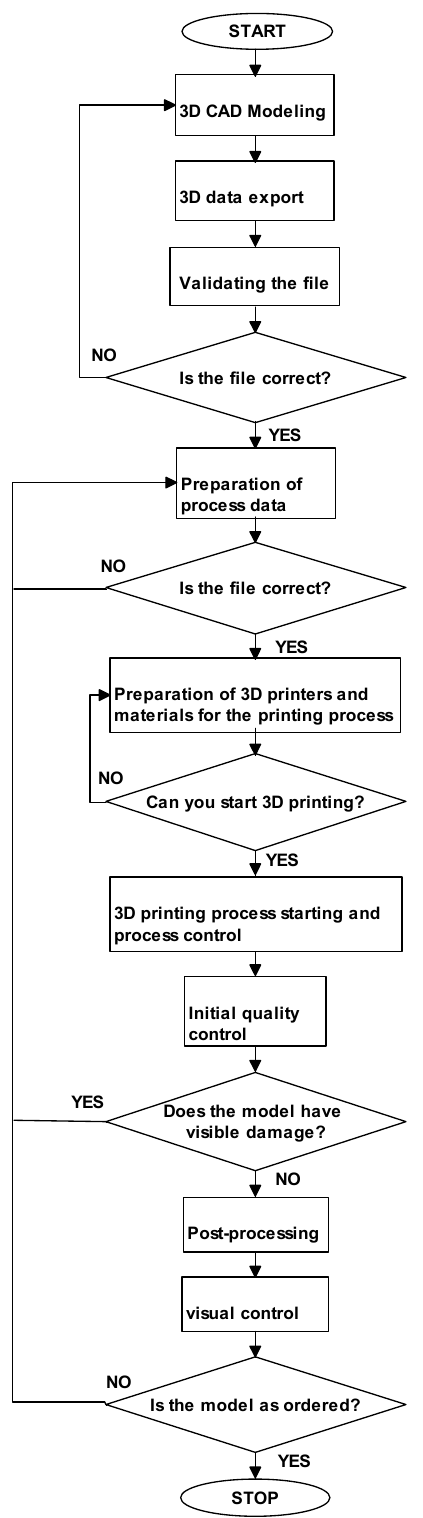
Figure 1. Algorithm of the quality control process for models manufactured for the purpose of visual presentation.